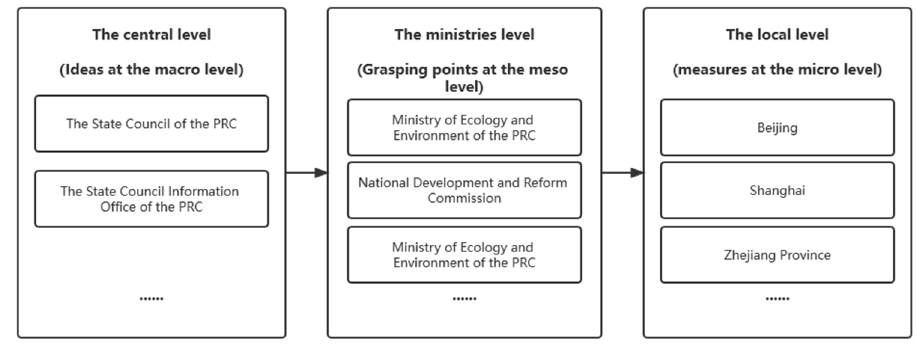
Figure 2. The roles and relationships of these main departments, ministries, commissions, and others. After that, this article converts these policies into plain text format for text prepro-